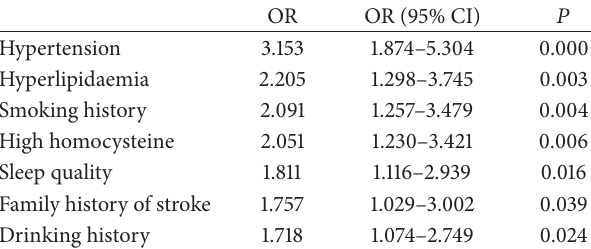
Table 2: Multivariate logistic regression analysis of risk factors for youth ischemic stroke. By multivariate logistic regression analysis, relative risk factors for youth IS, from highest to lowest, were hyper- tension, hyperlipidaemia, smoking history, high homocysteine, and poor sleep